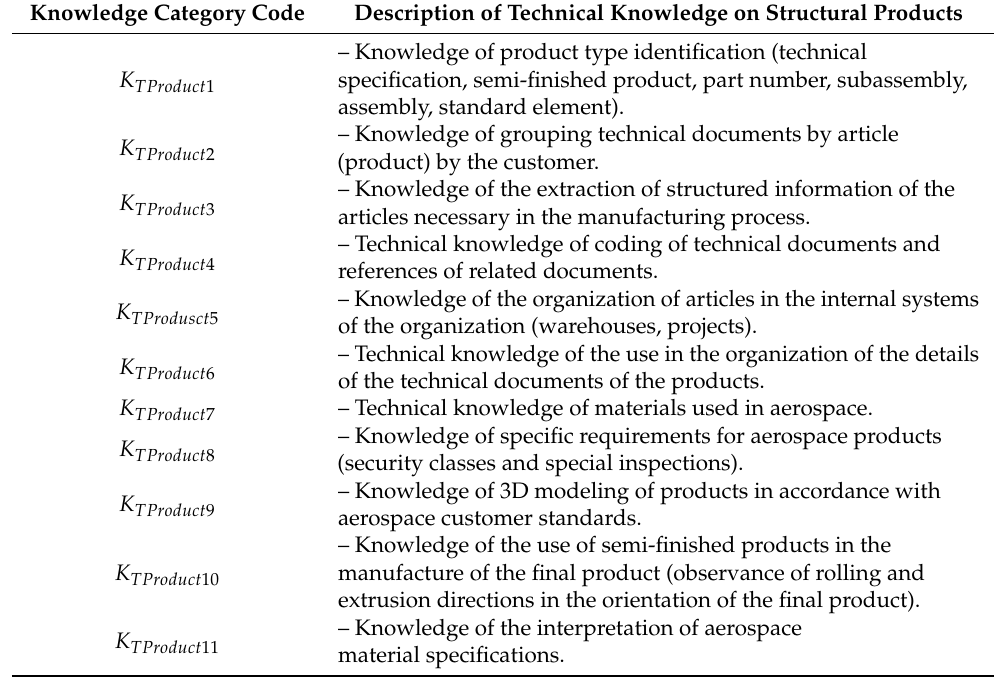
Table 7. List of technical knowledge of aerospace structural